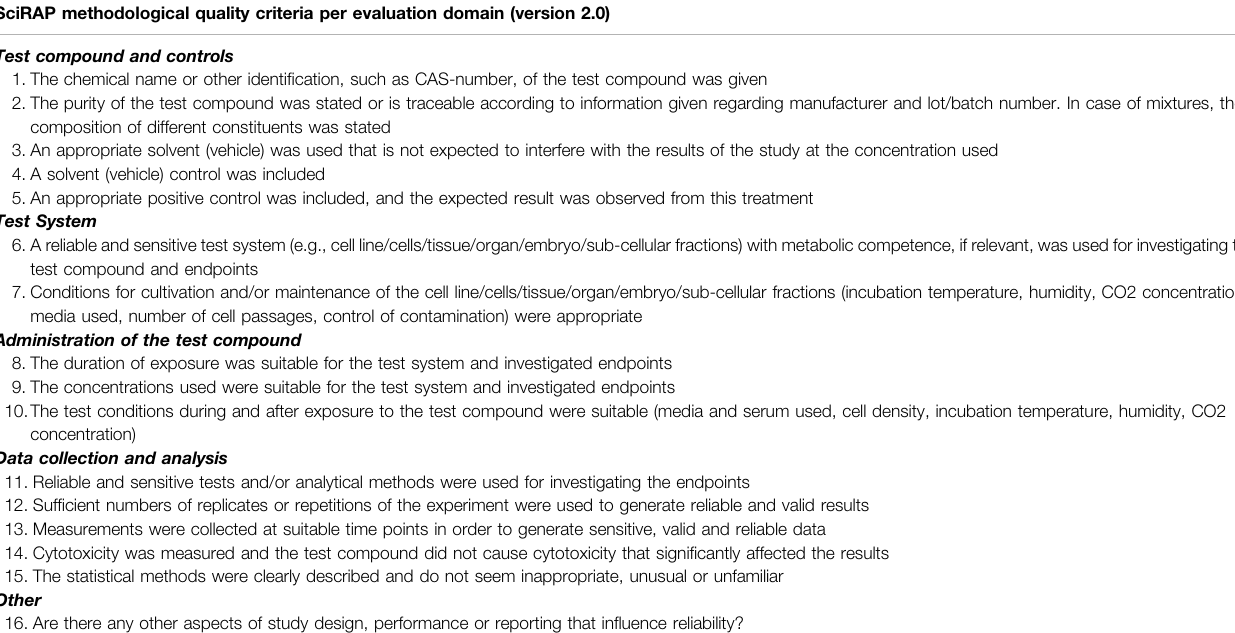
TABLE 2 | SciRAP criteria for assessing methodological quality of in vitro toxicity studies (version 2.0). SciRAP methodological quality criteria per evaluation domain (version 2.0)